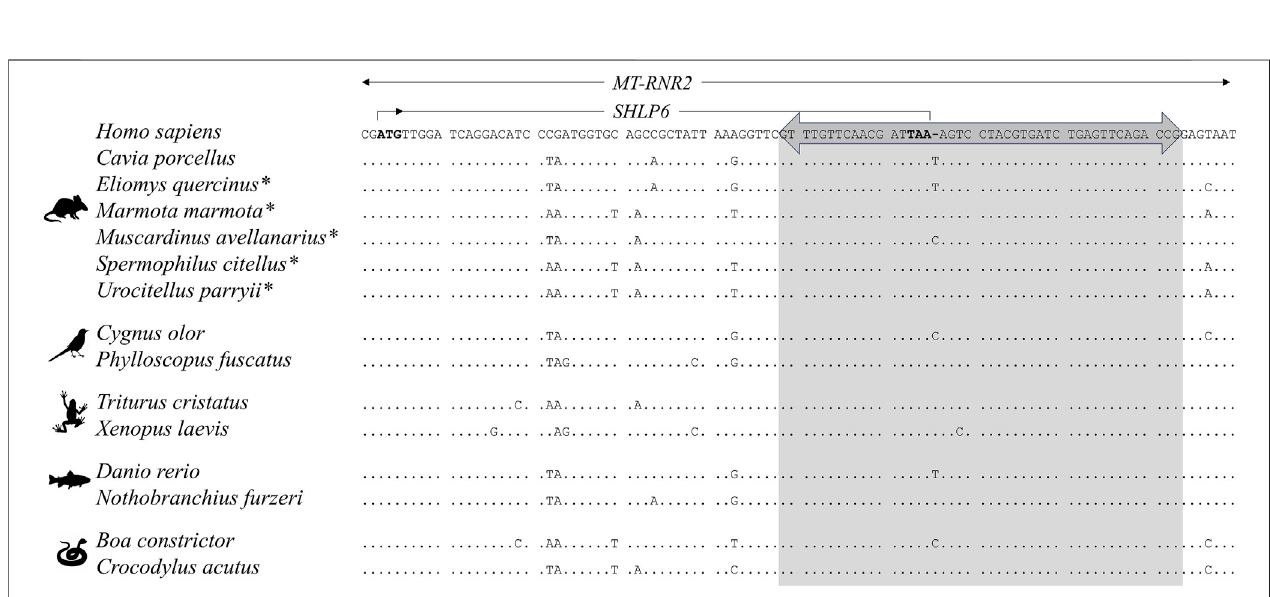
Figure 2 ). The 20- μ L reaction for mitogenome ampli fi cation consisted of 1 × Phusion HF Buffer containing 1.5 mM MgCl 2 (Thermo Fisher Scienti fi c, Waltham, MA, United States), 0.2 mM of each dNTP (Solis Biodyne, Tartu, Estonia), 0.5 mM of additional MgCl 2 , 1 × Solution S (Solis Biodyne), 0.5 μ M of each primer, 0.6 units Phusion Hot Start II DNA polymerase (Thermo Fisher Scienti fi c) and ∼ 10 ng genomic DNA. The cycling conditions consisted of 98 ° C for 2 min, followed by 30 cycles of 95 ° C for 10 s, 66 ° C for 25 s and of 72 ° C for 500 s and fi nal extension at 72 ° C for 5 min. Speci fi city of ampli fi cation was